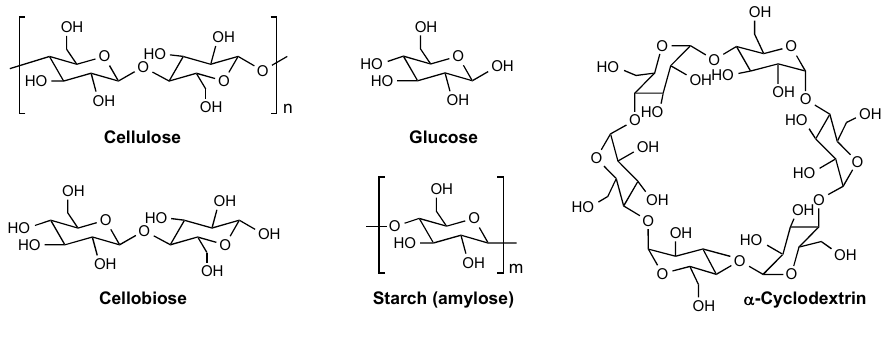
Figure 12. The structures of saccharides used in this